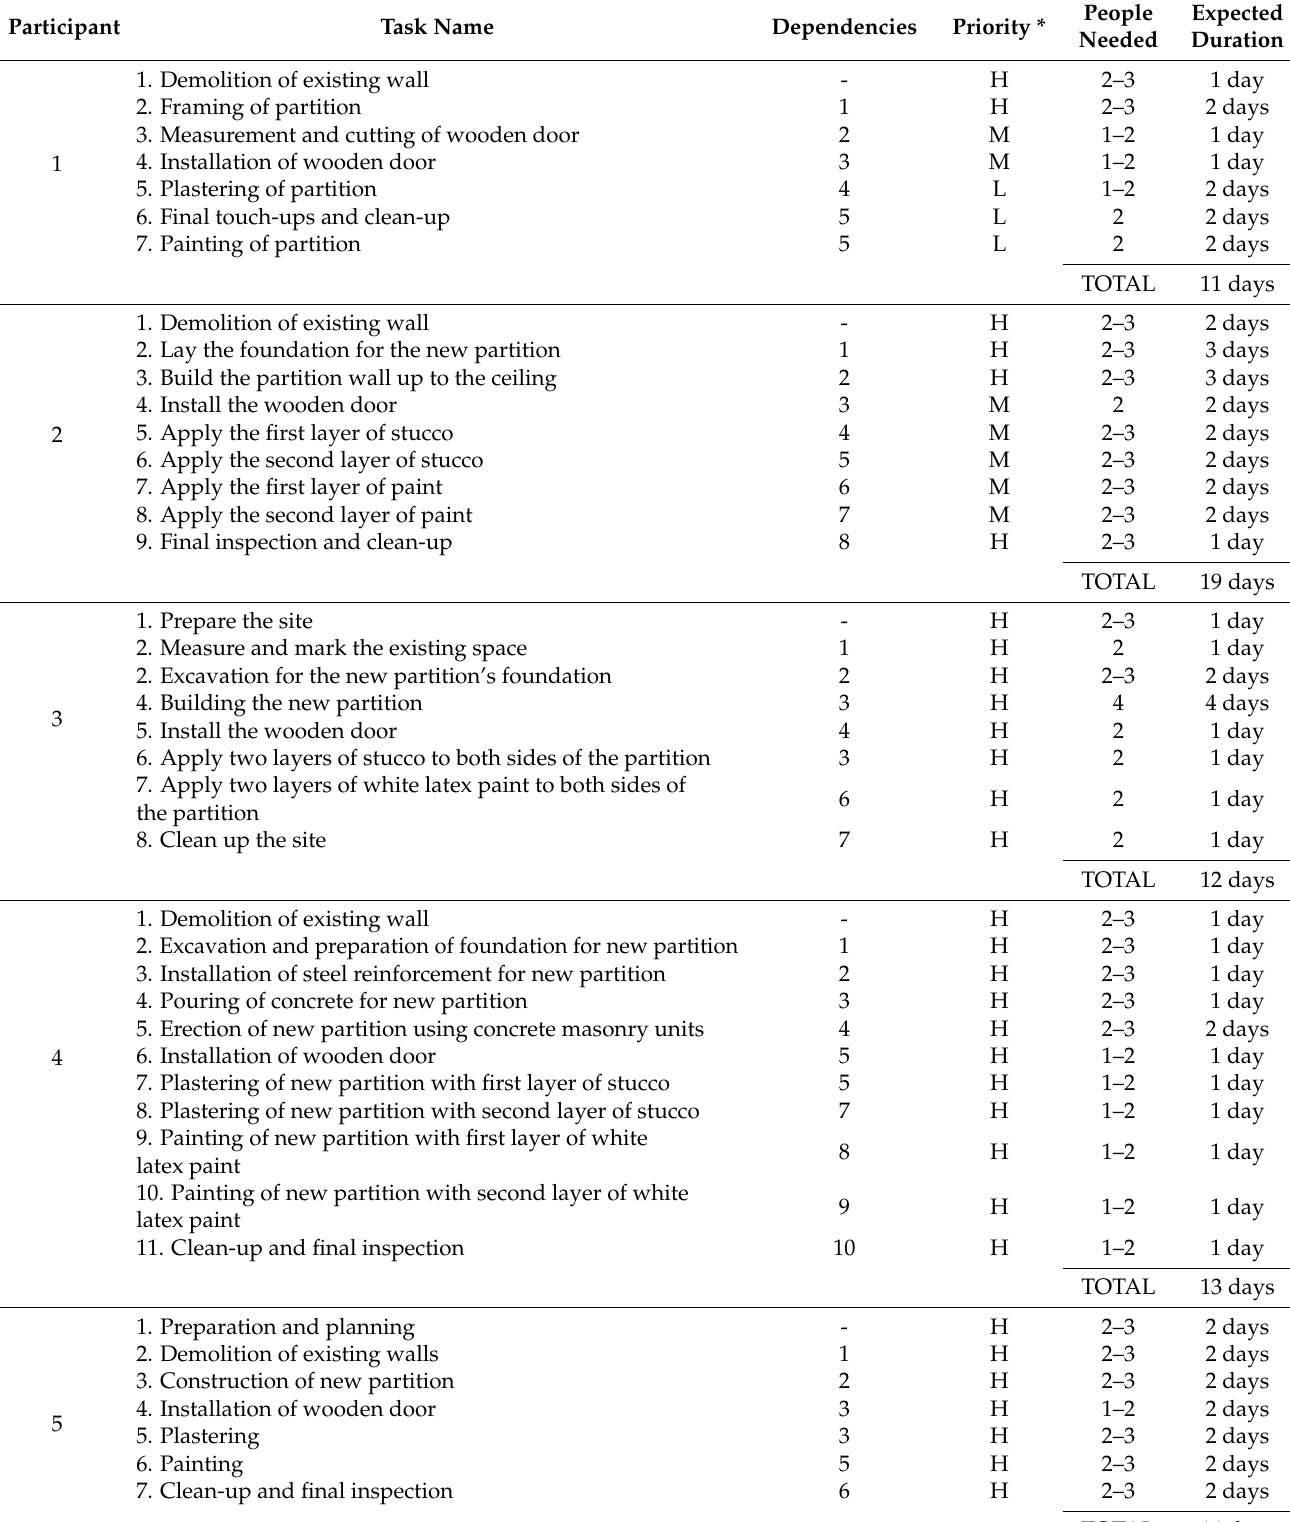
Table A1. Summary of tasks and related information from the six participants during their interaction with ChatGPT using the original prompt describing the scope of